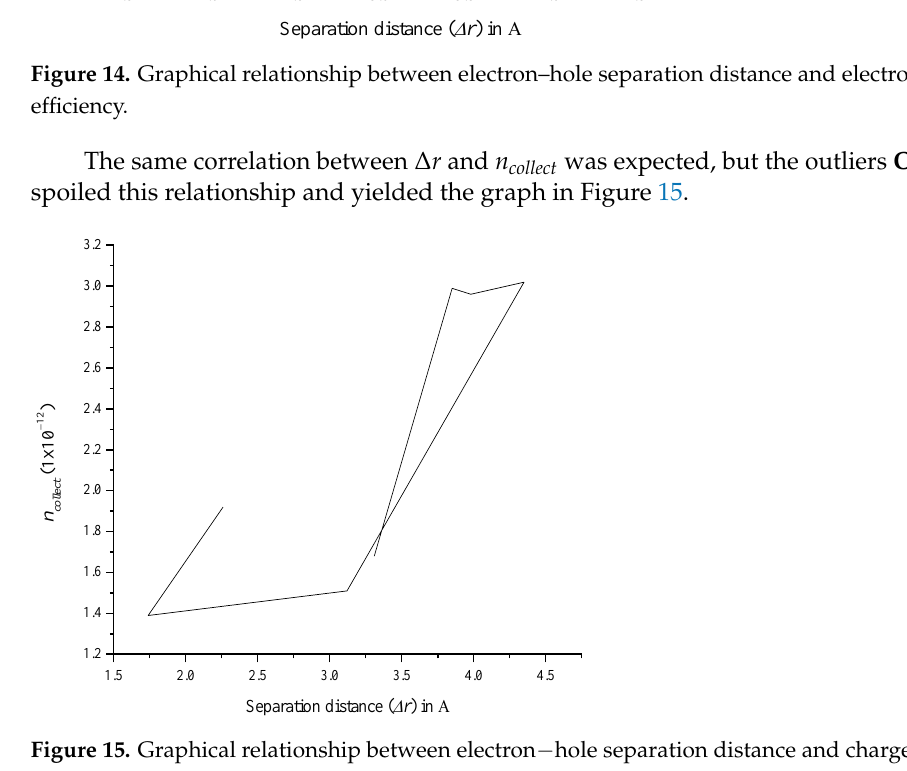
Figure 15. Graphical relationship between electron − hole separation distance and charge collection efficiency.